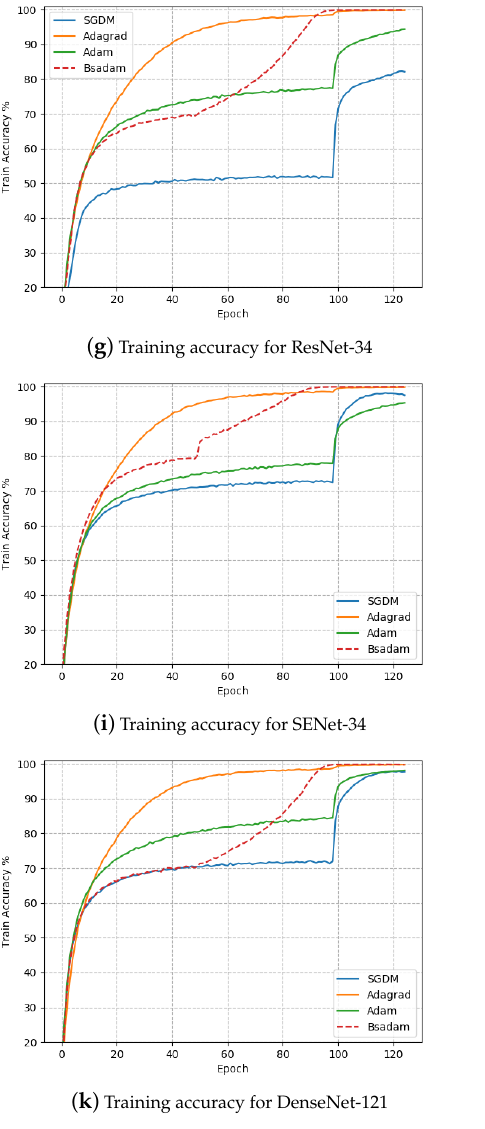
Figure 5. Training and test accuracy for ResNet-34, SENet-34 and DenseNet-121 on